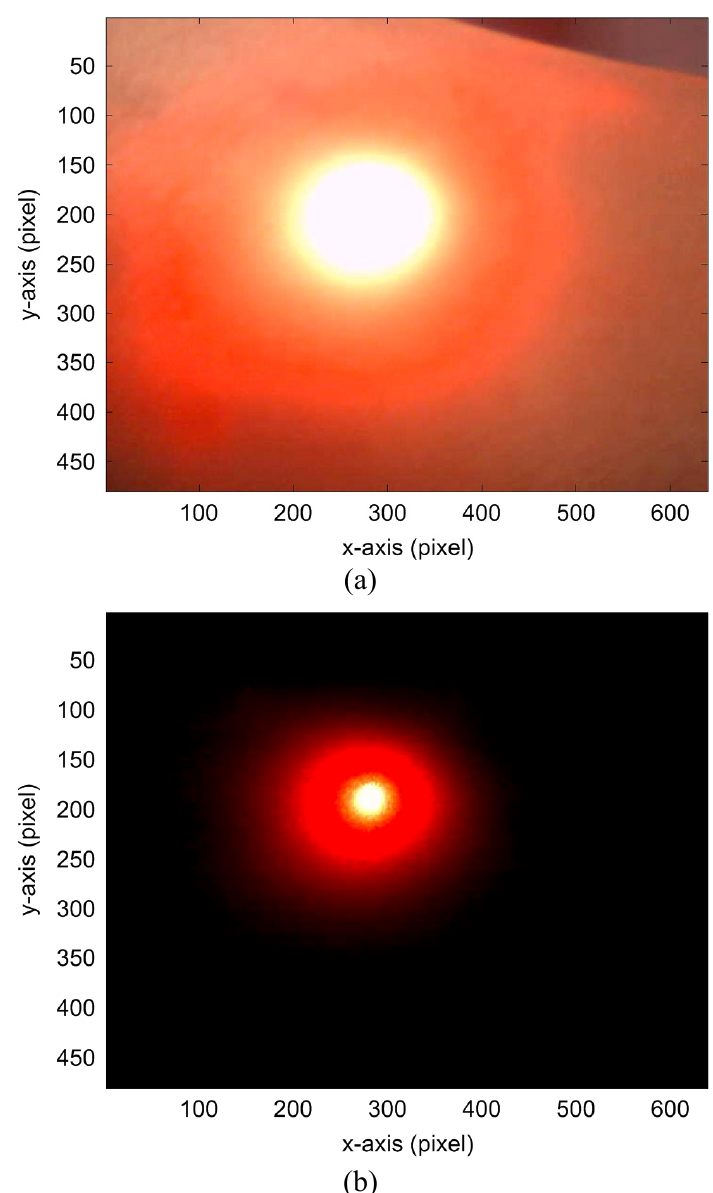
Figure 3. The contours of laser spots after ET values of the CMOS image sensor were set to: (a) 40 and (b)